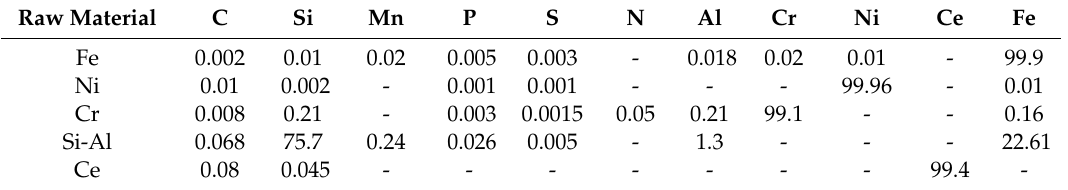
Figure 4. Liquid regions of Al 2 O 3 -SiO 2 -RE 2 O 3 systems.